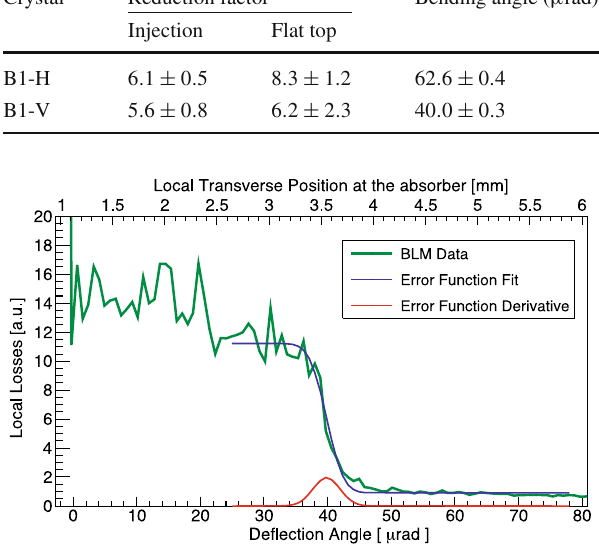
Fig. 6 Beam losses as a function of jaw position and the equivalent deflection at collimator position, recorded at the TCSG.D4L7.B1 dur- ing a linear scan with vertical crystal in channeling orientation. The col- limator used as absorber has an active jaw of 1 m of CFC (see Table 1) that does not stop all the energy carried by the channeled halo, but is adequate for the measurement of deflection